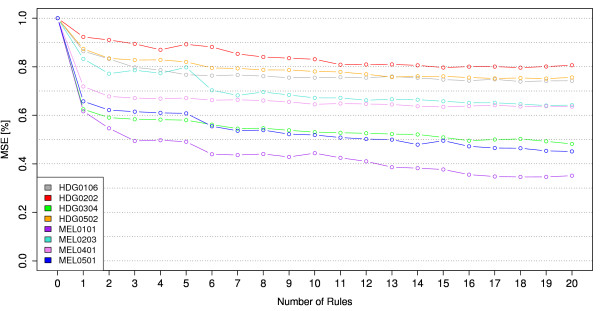
Reduction of the MSE obtained by the best bootstrapped tree for different tree sizes.